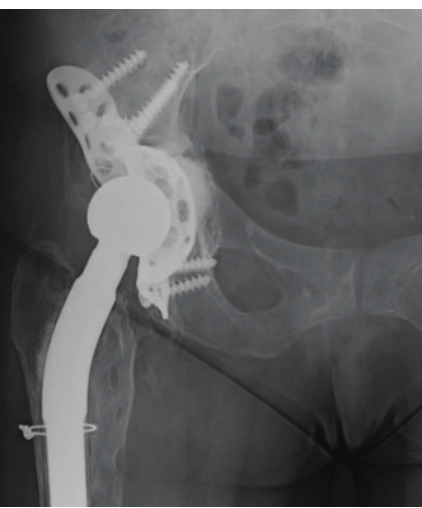
Figure 1: Radiological anteroposterior radiographs of the pelvis showing the Burch Schneider metal cage.